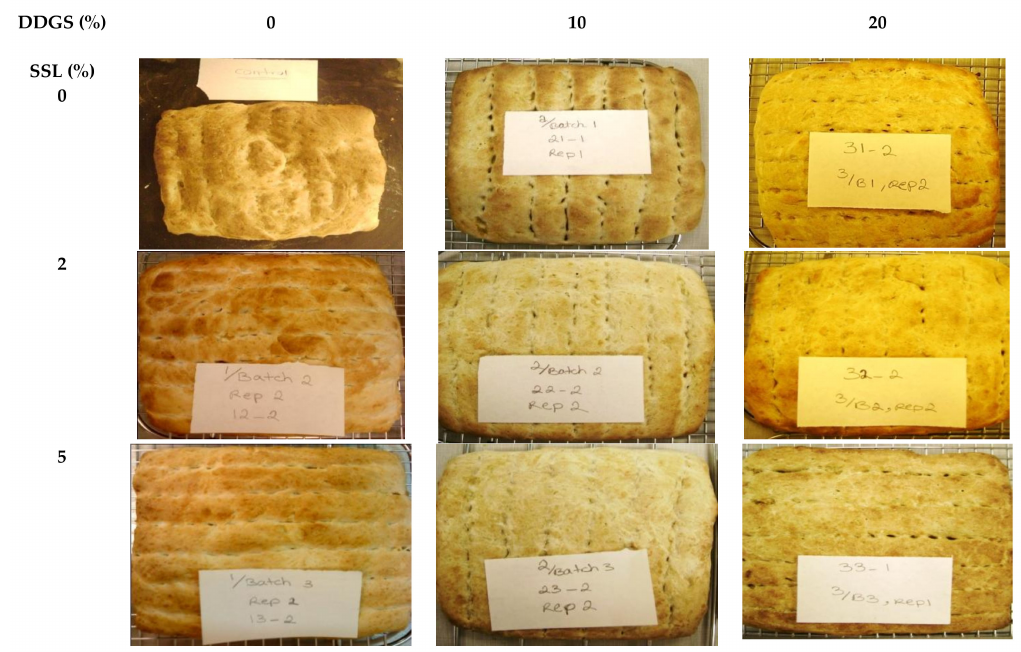
Figure 1. Final bread products baked with different blends of distillers dried grains with solubles (DDGS) and sodium stearoyl-2-lactate